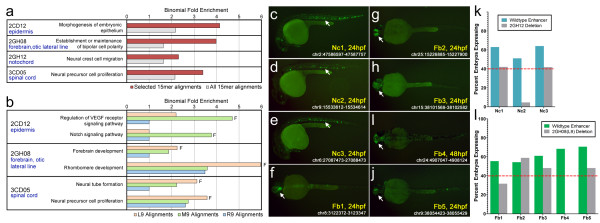
Short sequences contribute to endogenous developmental zebrafish enhancers. (a,b) Alignments of 15-bp multiplexed sequences and 9-bp sequences identified by functional dissection were intersected with predicted enhancers (defined by H3K4me1-positive, H3K4me3-negative ChIP-seq regions [12]). We then used GREAT [41] to find enriched ontology terms for nearby genes. In each case, a term consistent with the expression pattern was identified, suggesting that the sequences identified by our screen are performing specific roles in developing vertebrates. Plotted are binomial fold enrichment values for the specific 15-bp or 9-bp alignments. Functional 9-bp sequences are depicted by the letter F. To control for common developmental gene ontology terms, we include the binomial fold enrichment values for the H3K4me1+/me3- alignments of all 184 constructs (a) or the non-functional 9-bp sequences identified by functional dissection (b). We tested enhancer activity of 20 1,000-bp regions from the zebrafish genome that overlap with H3K4me1/me3- signal and contain an alignment for 2GH12/notochord or the 2GH08(L9)/brain sequence. (c-e) Three of ten 2GH12/notochord-containing regions (Nc1-3) showed strong notochord (Nc) enhancer expression at 24 hpf. (f-j) Five of ten 2GH08(L9)/brain-containing sequences (Fb1-5) were strong forebrain (Fb) enhancers at 24 or 48 hpf. The chromosomal coordinates of each enhancer are indicated (Zv9 zebrafish genome assembly) as well as the time point with the strongest expression. (k,l) Deletion of the 2GH12/notochord or 2GH08(L9)/brain sequence from the 1,000-bp enhancers leads to a reduction and, in several cases, abolition of the observed enhancer signal. Bars represent the percentages of fish exhibiting expression in the notochord (k) and forebrain (l) at the indicated time point provided in the pictures above. The red dotted line represents the 40% consistency cut-off used for this study.